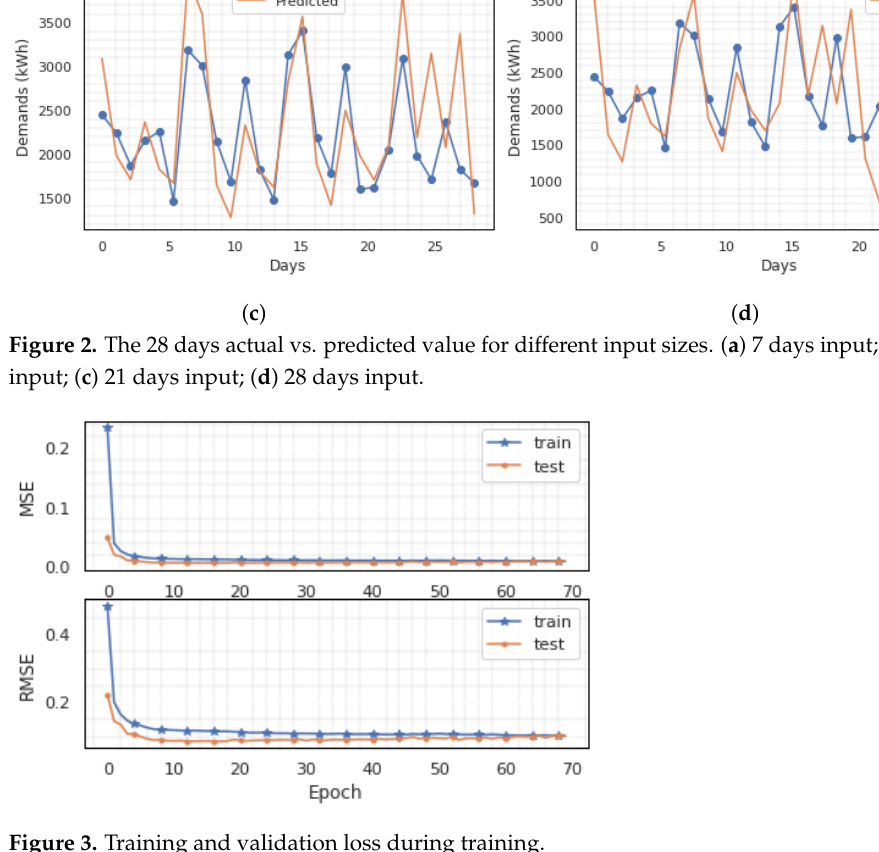
Figure 3. Training and validation loss during